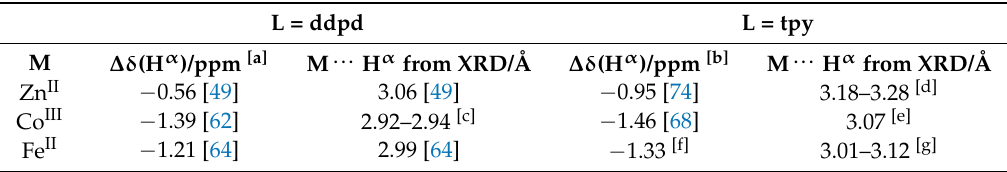
Table 3. Coordination shift ∆ δ = δ (complex) − δ (ligand) of 1 H NMR resonances of H α in